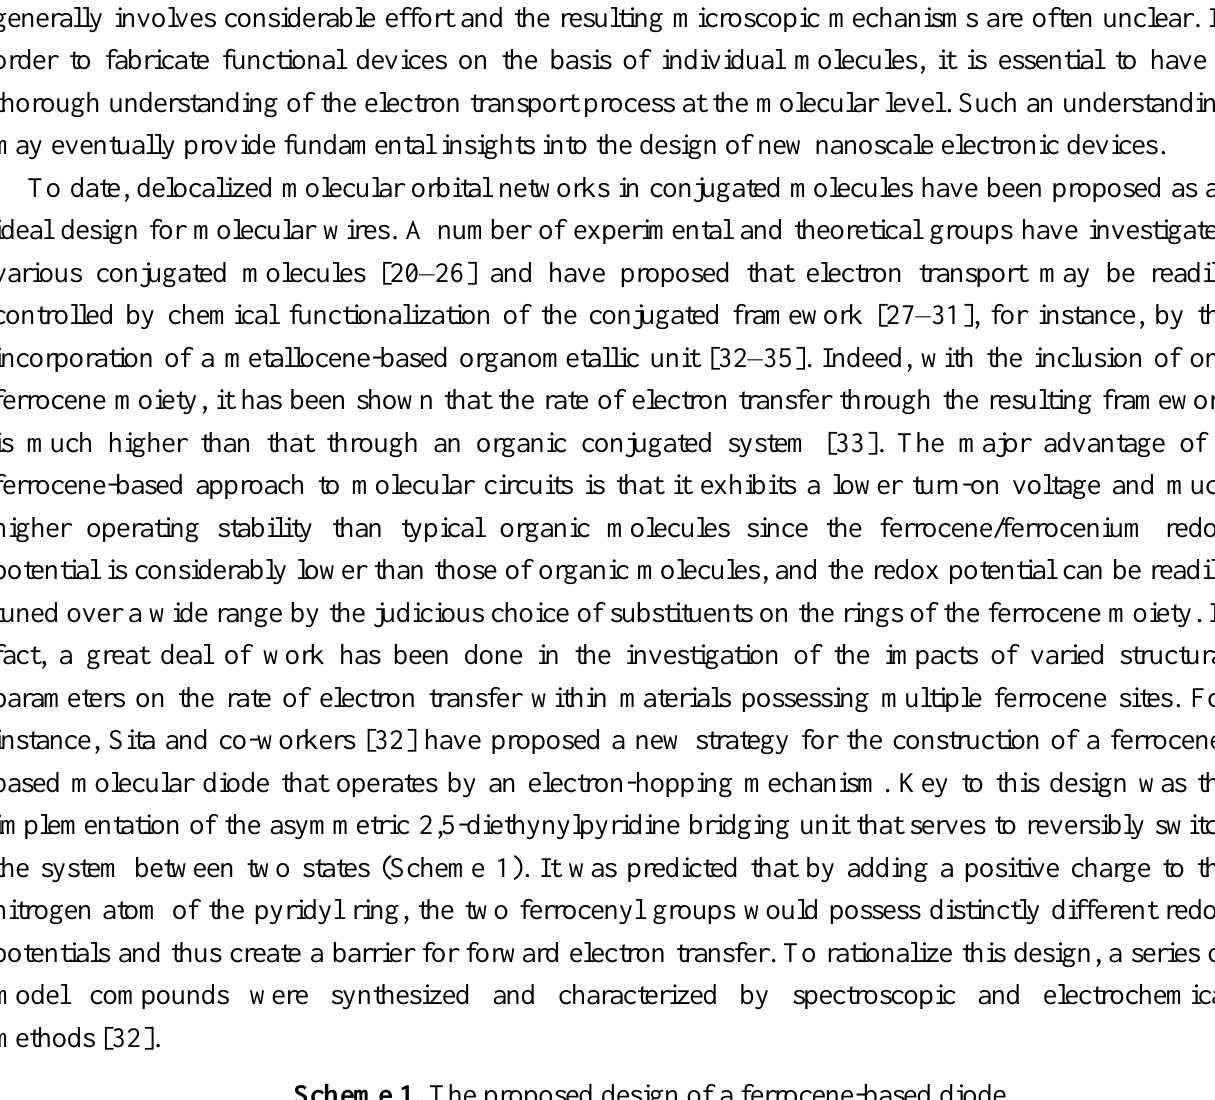
Scheme 1. The proposed design of a ferrocene-based